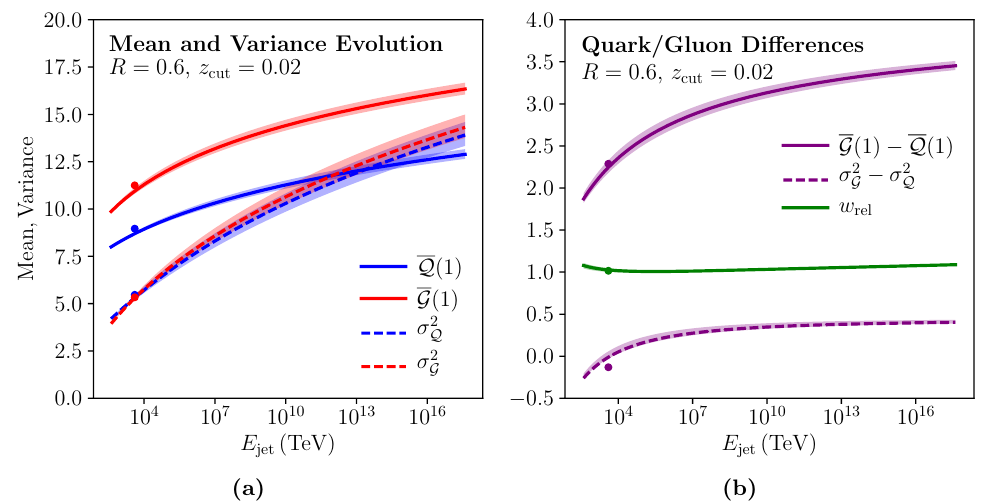
Figure 18. (a) RG evolution of means and variances of the quark-singlet and gluon GFFs for the soft drop multiplicity with z cut = 0 : 02. (b) RG evolution of the mean/variance di(cid:11)erences, which asymptotically approach constants. Also shown is the relative width w rel de(cid:12)ned in eq. (5.26), which increases slowly. For comparison, quantities extracted from Vincia at E jet = 4 TeV are shown as